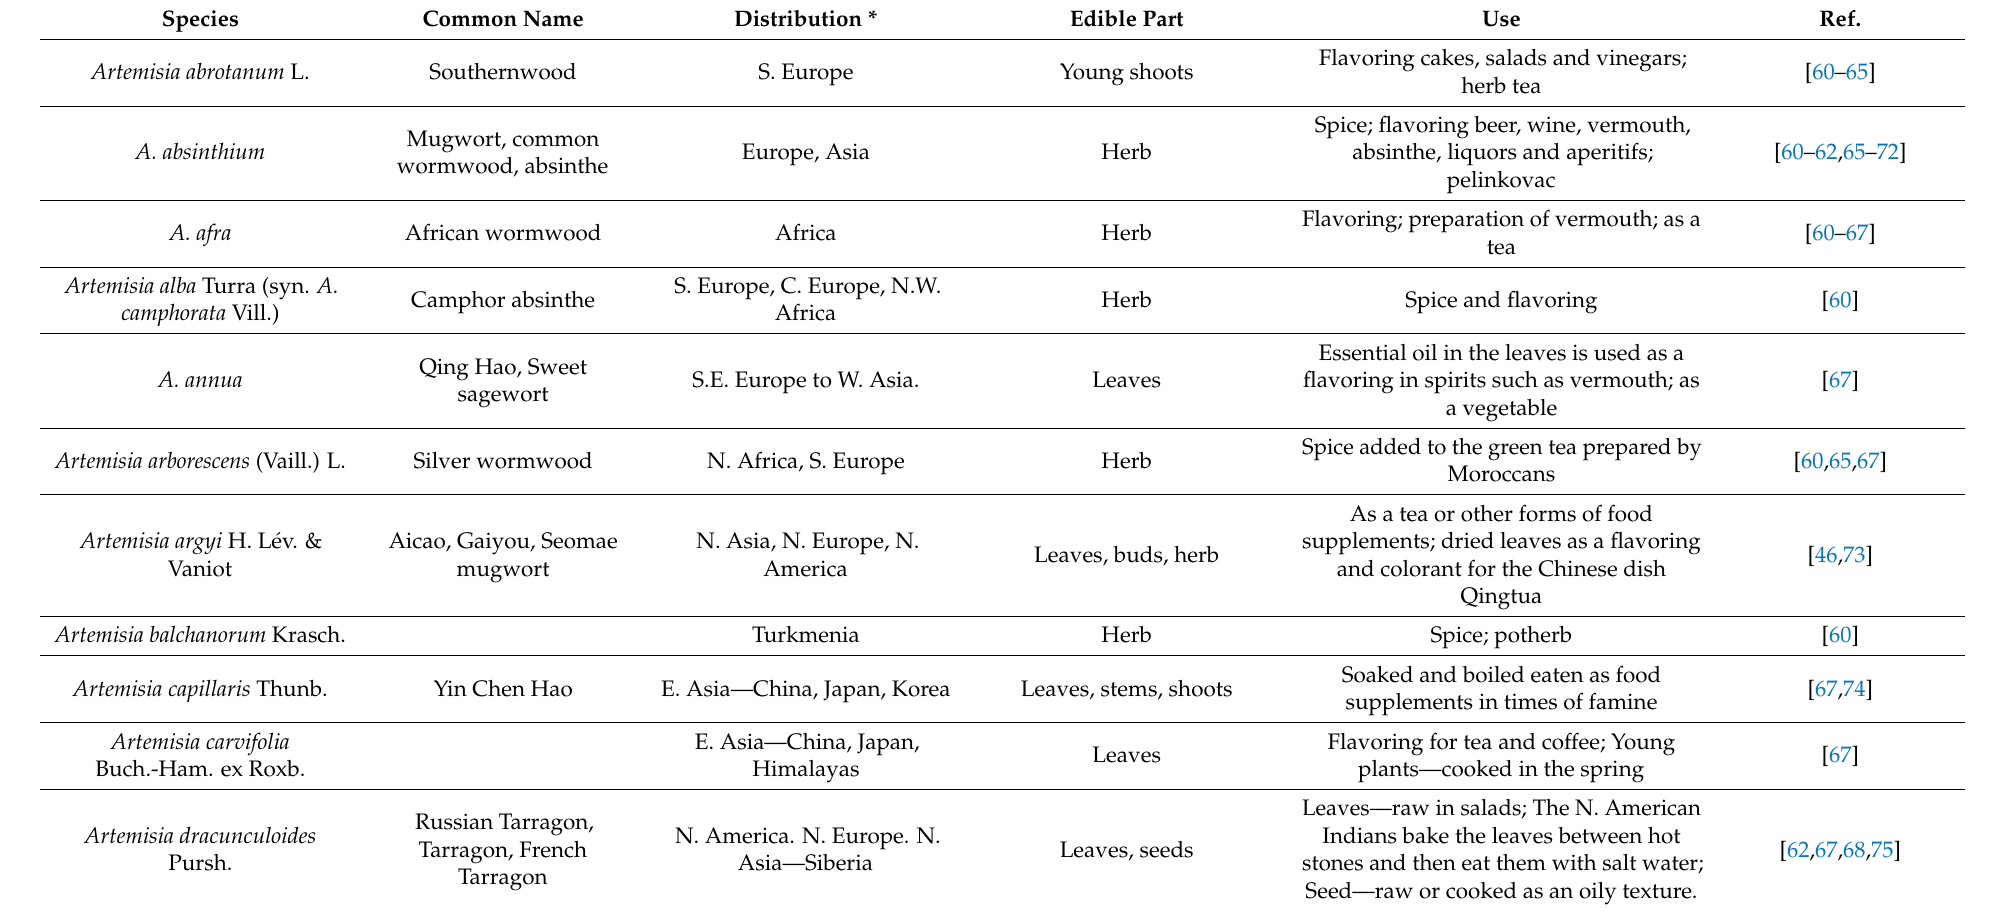
Table 1. Application of Artemisia species as food, spices, condiments and